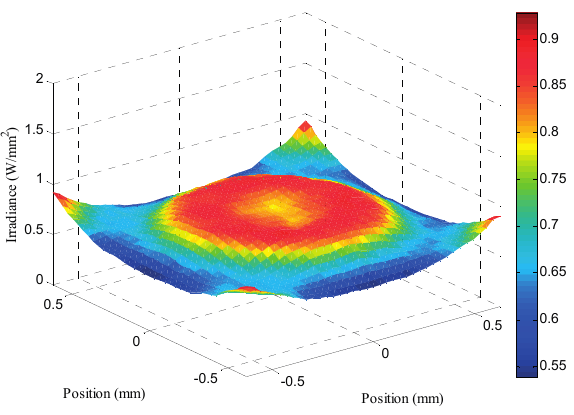
Figure 4. Irradiance distribution on the receiver under normal incidence for the Fresnel lens with KOD-type SOE.